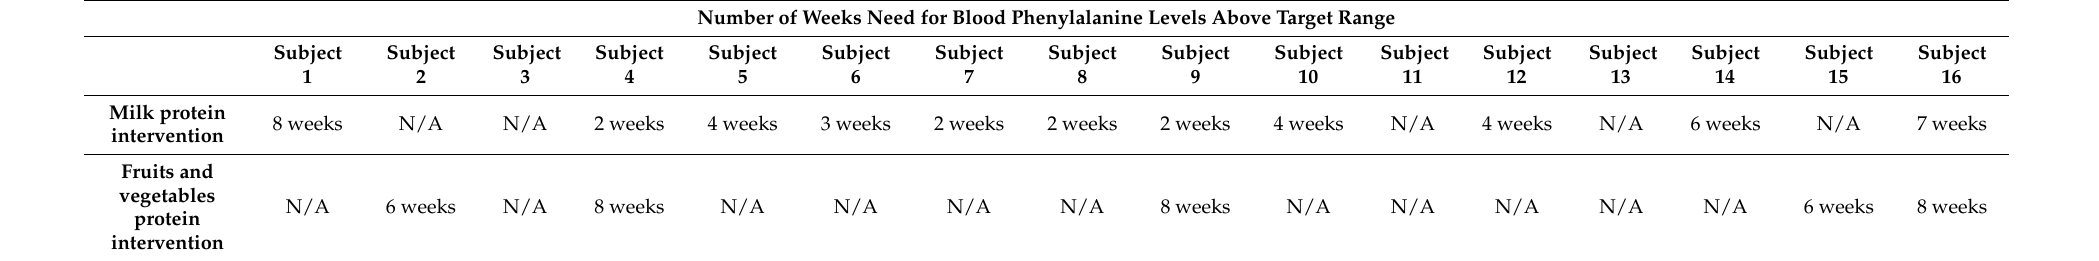
Table 4. Number of weeks taken for blood phenylalanine levels to elevate above upper target therapeutic range with each